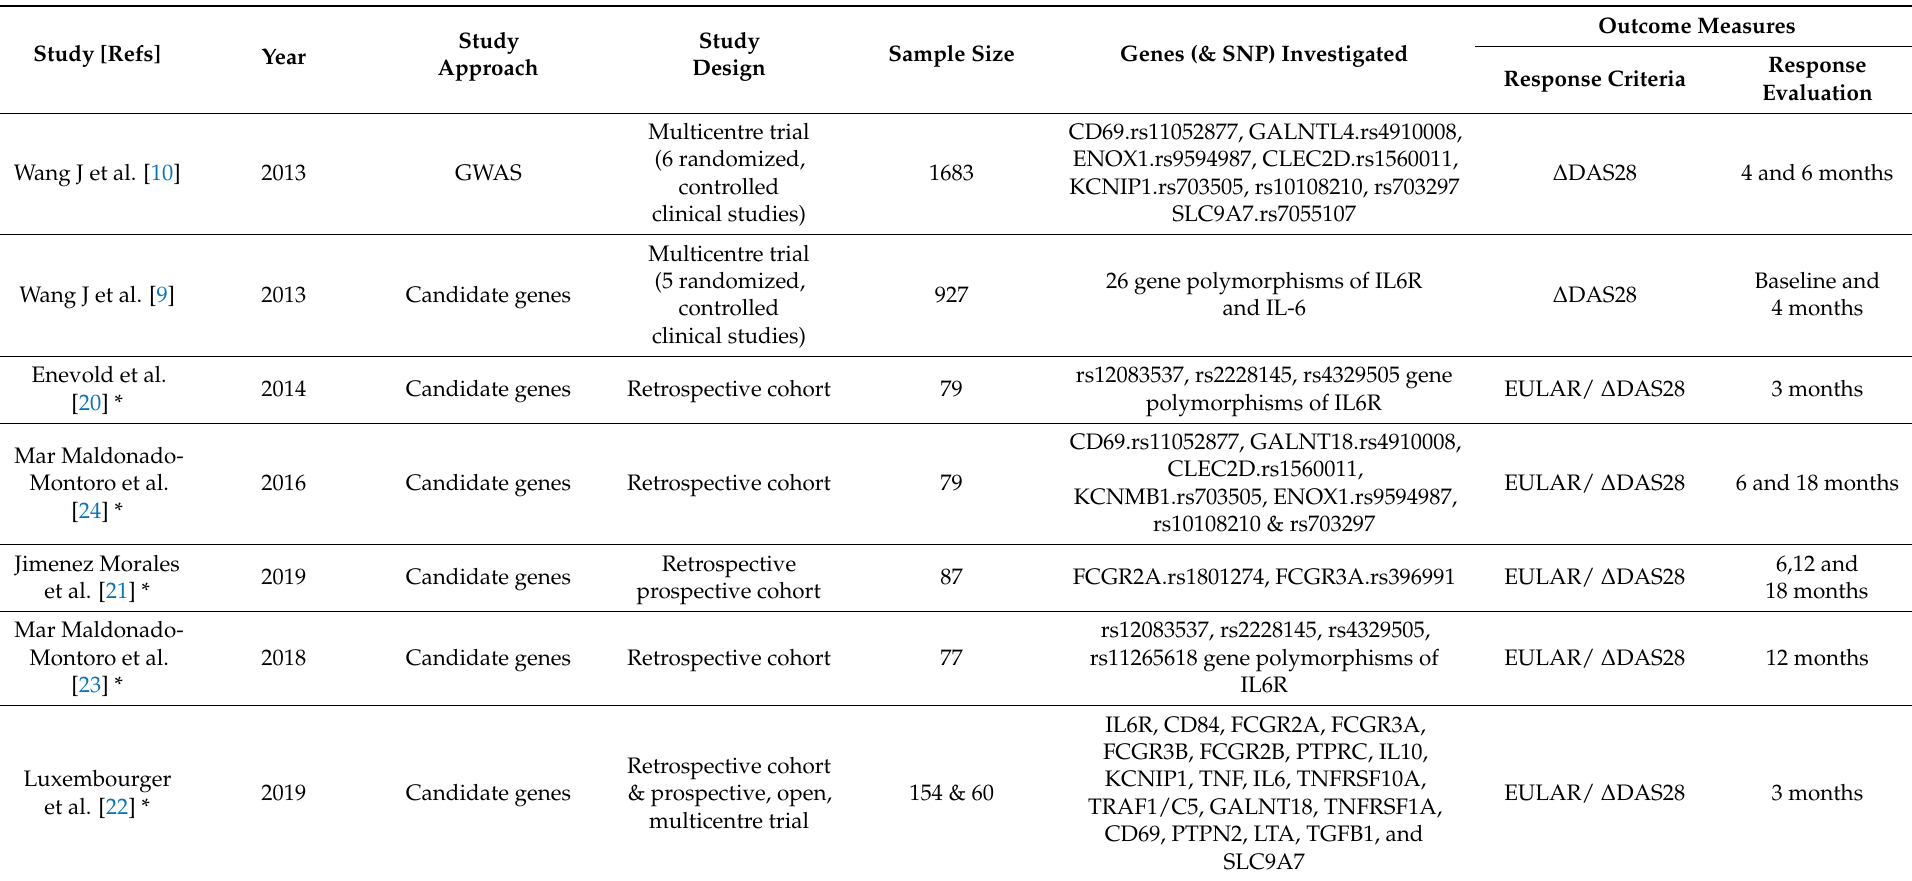
Table 1. Study characteristics of included research articles for